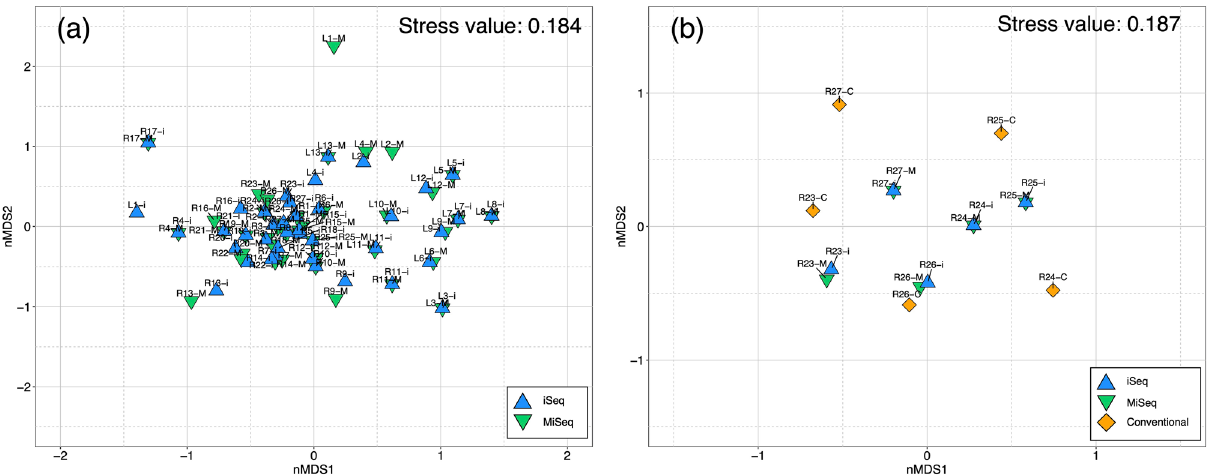
Figure 1. Two-dimensional NMDS plot of fish community using lake and river samples. ( a ) fish community of lake and river samples using iSeq and MiSeq. ( b ) fish community of five river samples using iSeq, MiSeq, and conventional methods. Blue triangles, green inverted triangles, and diamond shapes indicate the points of iSeq, MiSeq, and conventional methods, respectively. Labels with these shapes also indicate iSeq (–i), MiSeq (–M), and conventional methods (–C). The NMDS plots are performed based on incidence-based Jaccard index. Figure was created using “ggplot2” package version 3.3.0. supported on R program software 45 . Df † Sum of square Mean square F value R 2 Pr (> F)